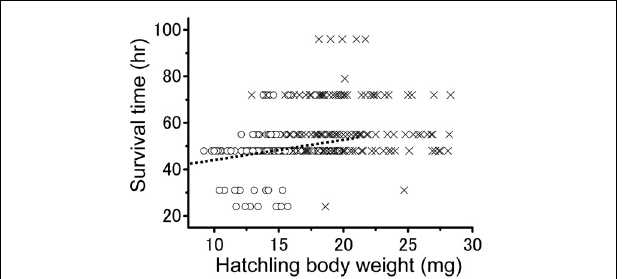
FIGURE 5 | The relationship between hatchling body weight and survival time in solitarious (open circle: from isolated-reared female) and gregarious hatchlings (crosses: from crowd-reared females) in Schistocerca gregaria under starvation conditions. A positive correlation was found only for the solitarious group (dotted line, r = 0 . 186; P < 0 . 01). n = 161 in the solitarious hatchling group and 133 in the gregarious hatchling group.